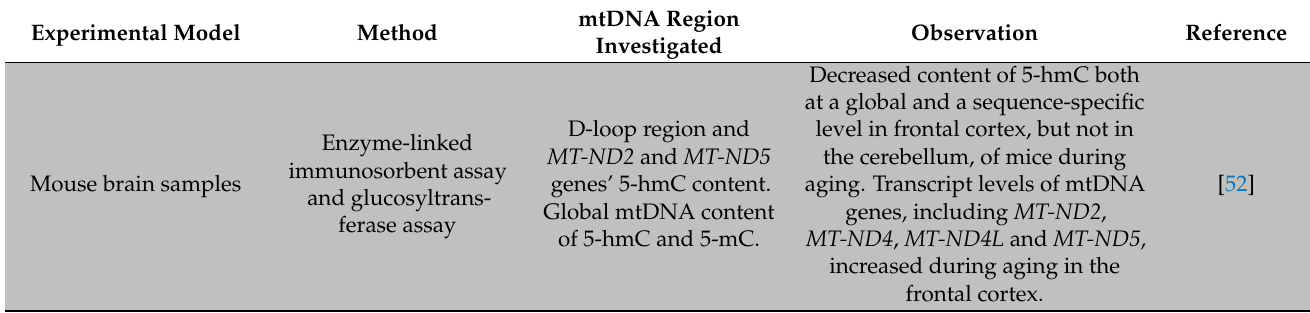
Table 3. mtDNA methylation studies in senescence and